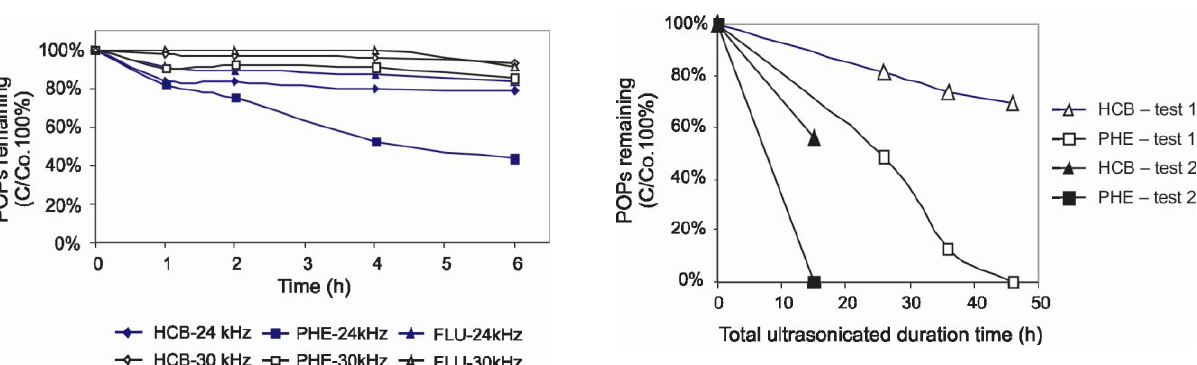
Fig. 4. POPs remaining (%) in kaolin after ultrasound irradia- tion process